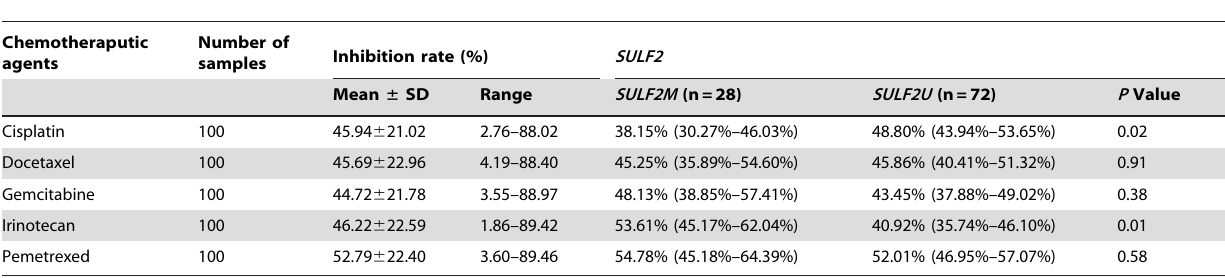
Table 2. Descriptive statistics of investigated